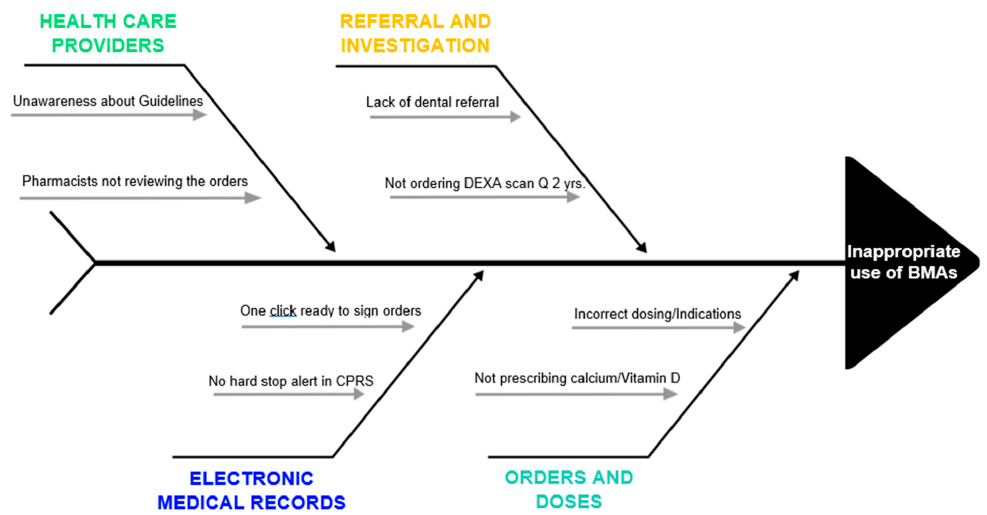
Figure 1. Fishbone diagram depicting pitfalls related to providers, electronic medical records, referral, investigation, and orders that contribute to inappropriate BMA use.